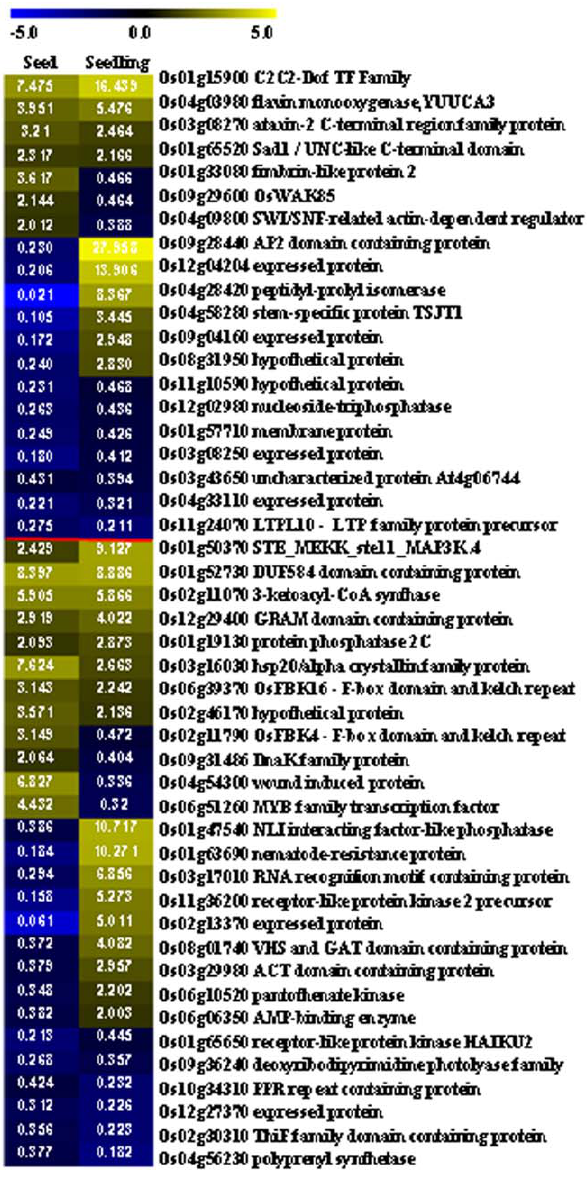
Figure 10. Common genes regulated by low temperature in seed and seedling. Genes above red line are regulated at 6 DAF and genes under red line are regulated at 12 DAF. The numbers indicate the ratios of gene expressions regulated by low temperature, and the color represents the log2 transformed ratio as indicated in the scale bar.